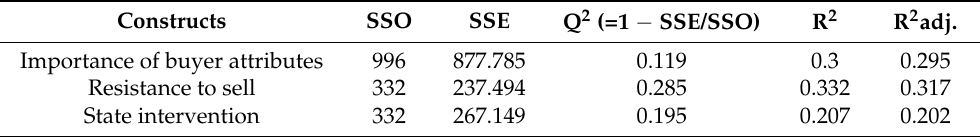
Table 6. The values of Stone–Geisser’s Q 2 , R 2 , and R 2 adj